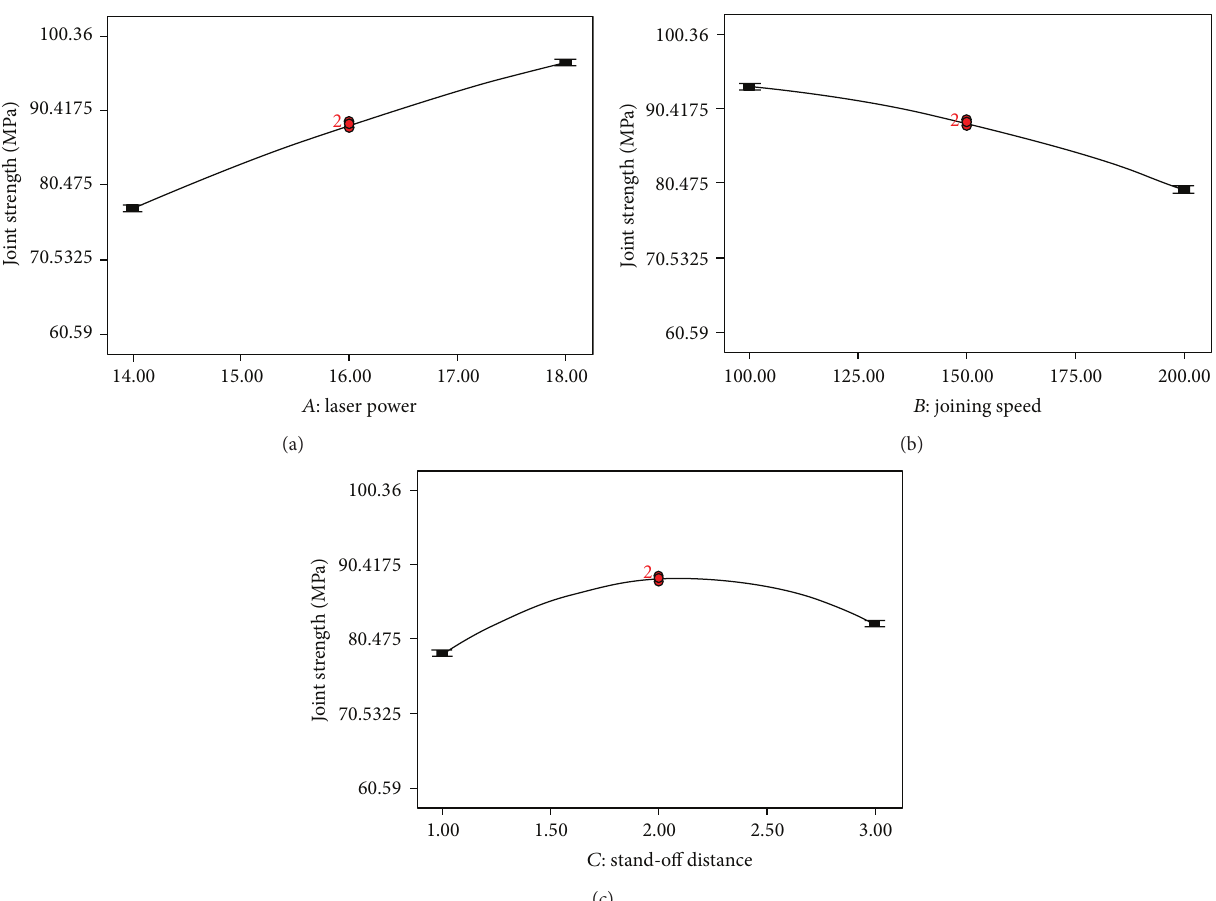
Figure 7: Single factor effect of laser power, joining speed, and stand-off distance on joint strength.